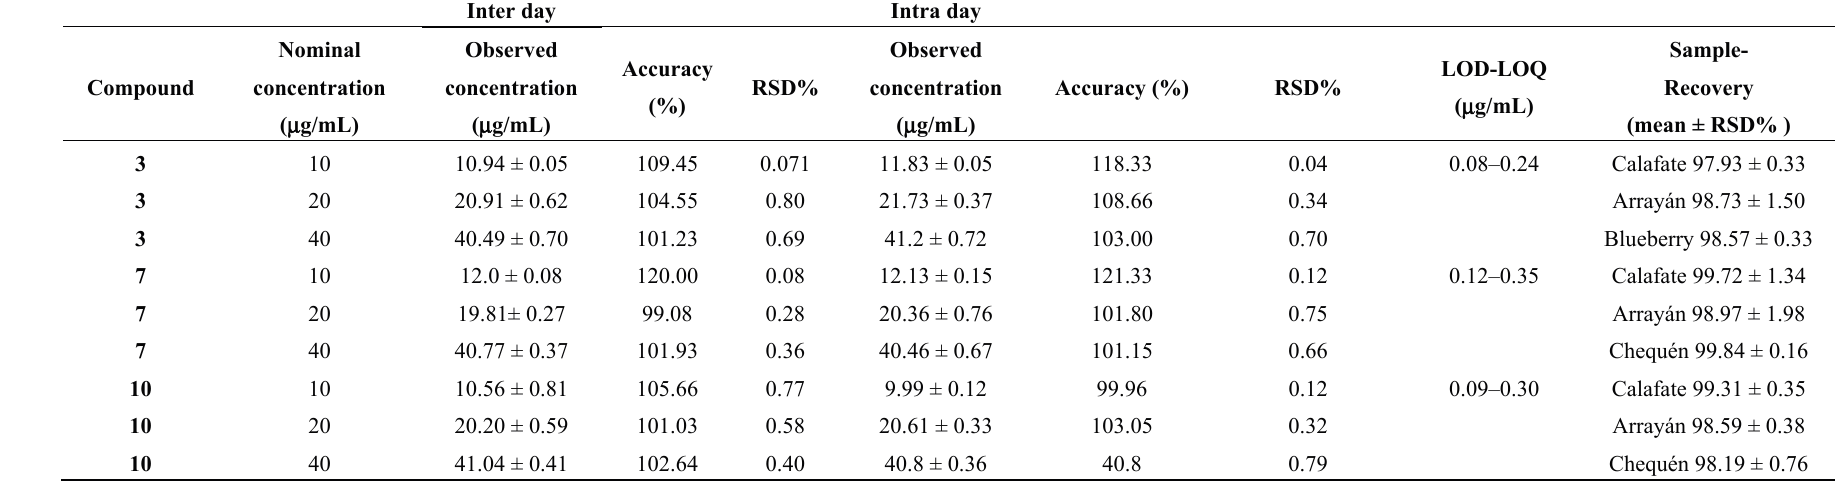
Table 4. Inter-day and Intra-day accuracy and precision (as RSD%), limits of detection (LOD) and quantification (LOQ) and recovery of three major anthocyanins (compounds 3 , 7 and 10